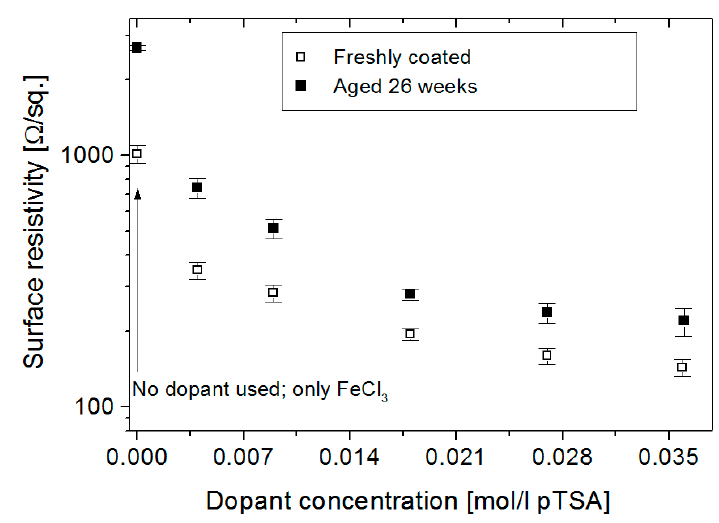
Figure 5. Surface resistivity (R S ) for recently coated and aged (six months) conducting PPy- p TSA Nylon-Lycra as a function of dopant concentration. Polymerisation time: 180 min.